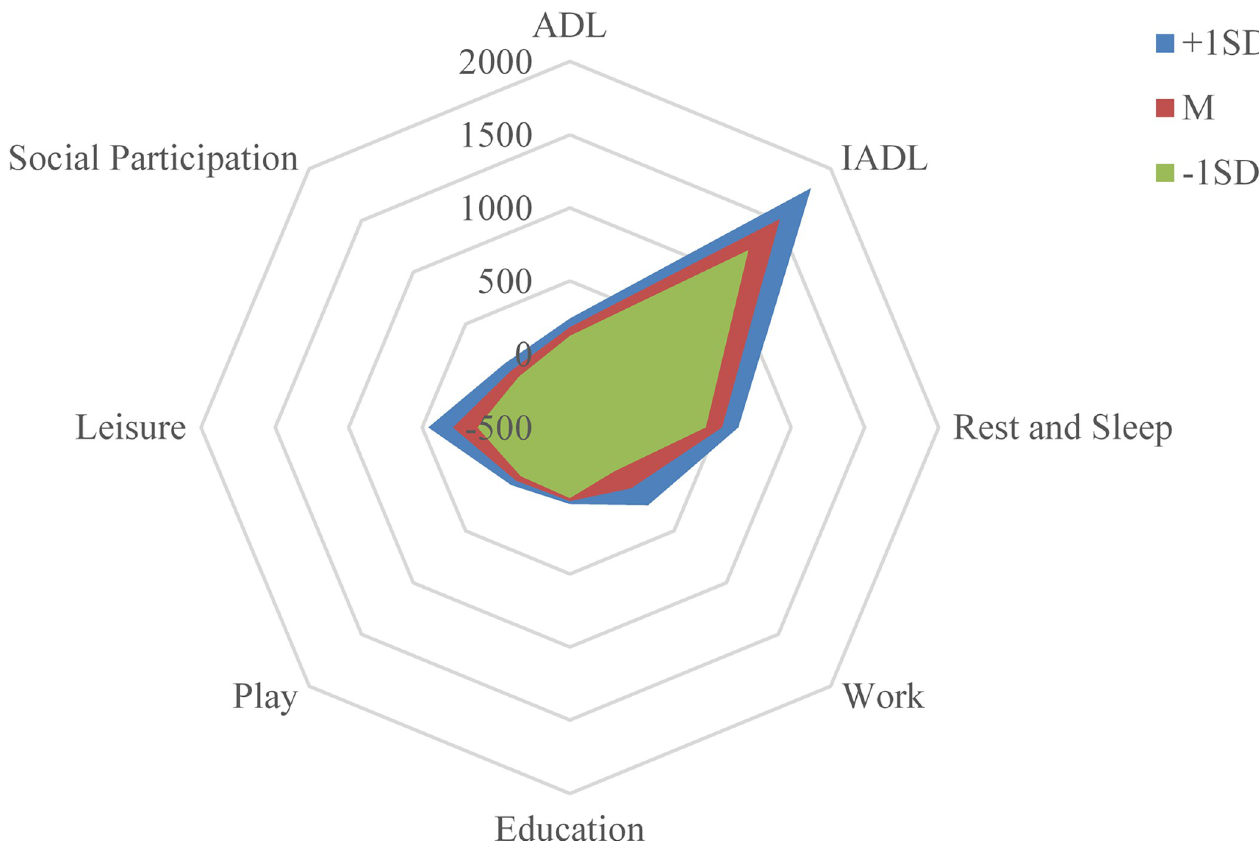
Fig 1. Mean value and 1 standard deviation (M ± 1SD) of the time-use according to occupations.